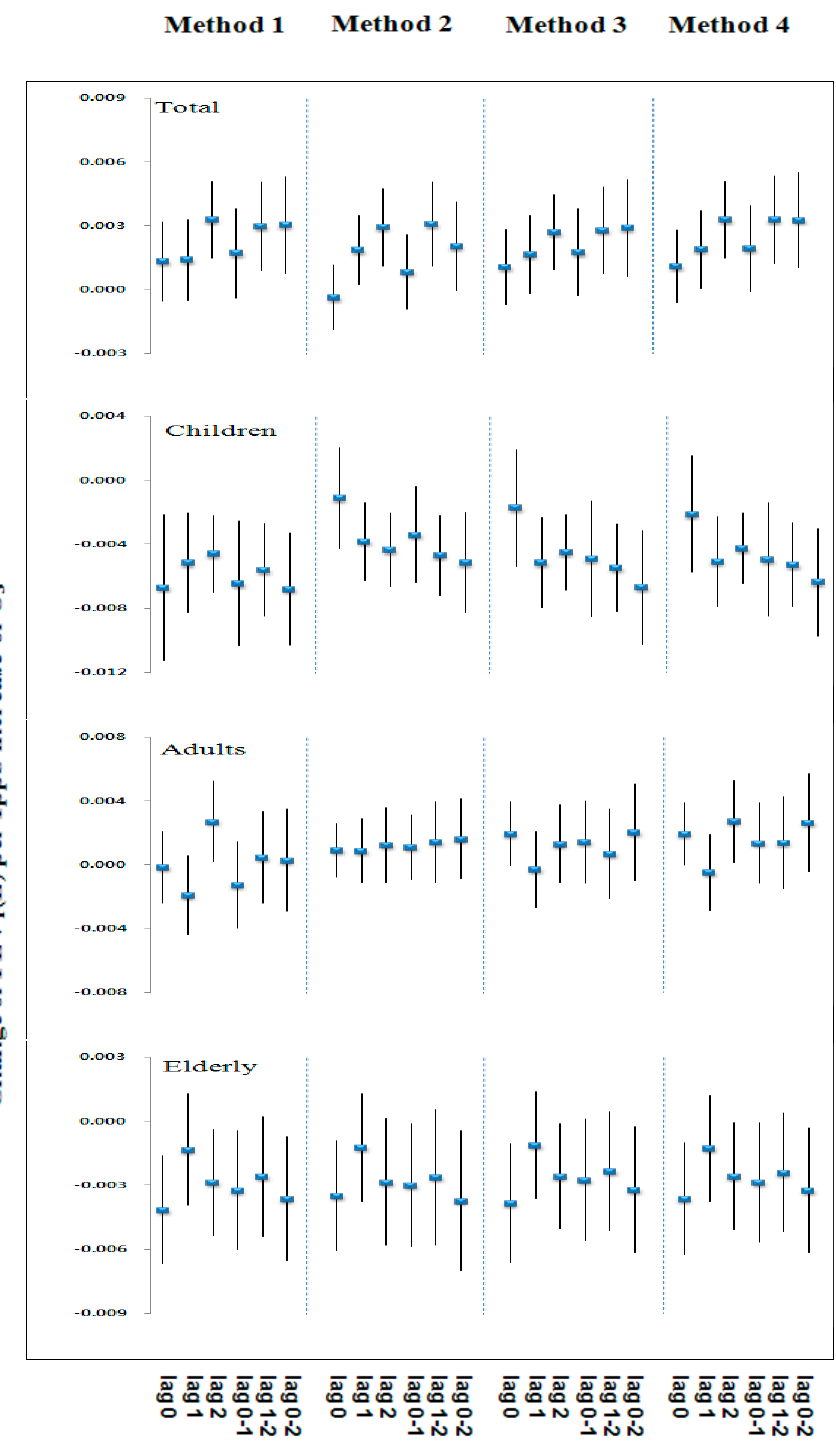
Figure 3. Change of FEV 1 (L) by O 3 concentration for various lags and methods for estimating exposure.